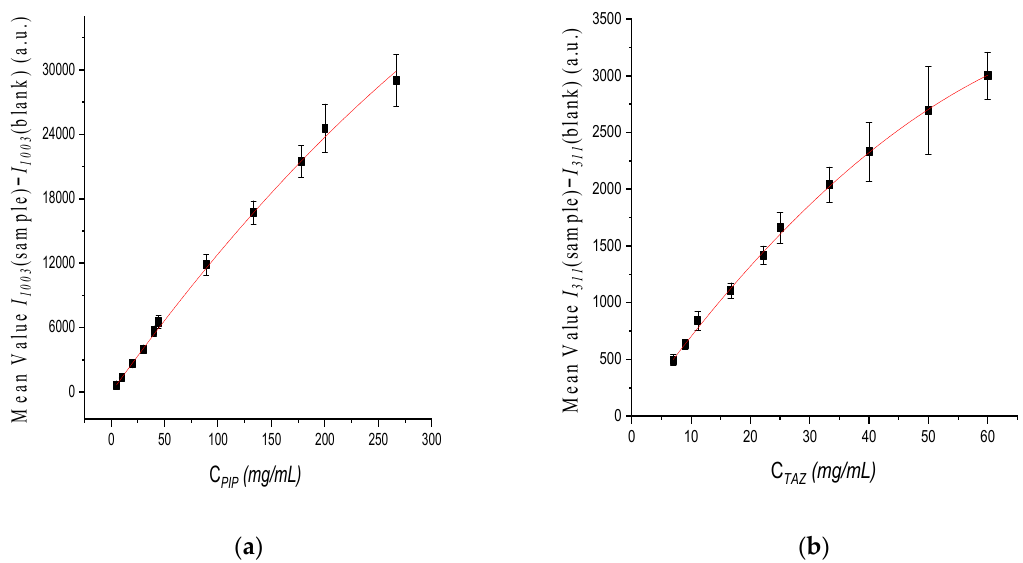
Figure 6. Calibration curve of: ( a ) PIP and ( b ) TAZ, after polynomial fitting of the points for the whole concentration range. The respective equations describing the calibration curves resulting after polynomial fitting were: